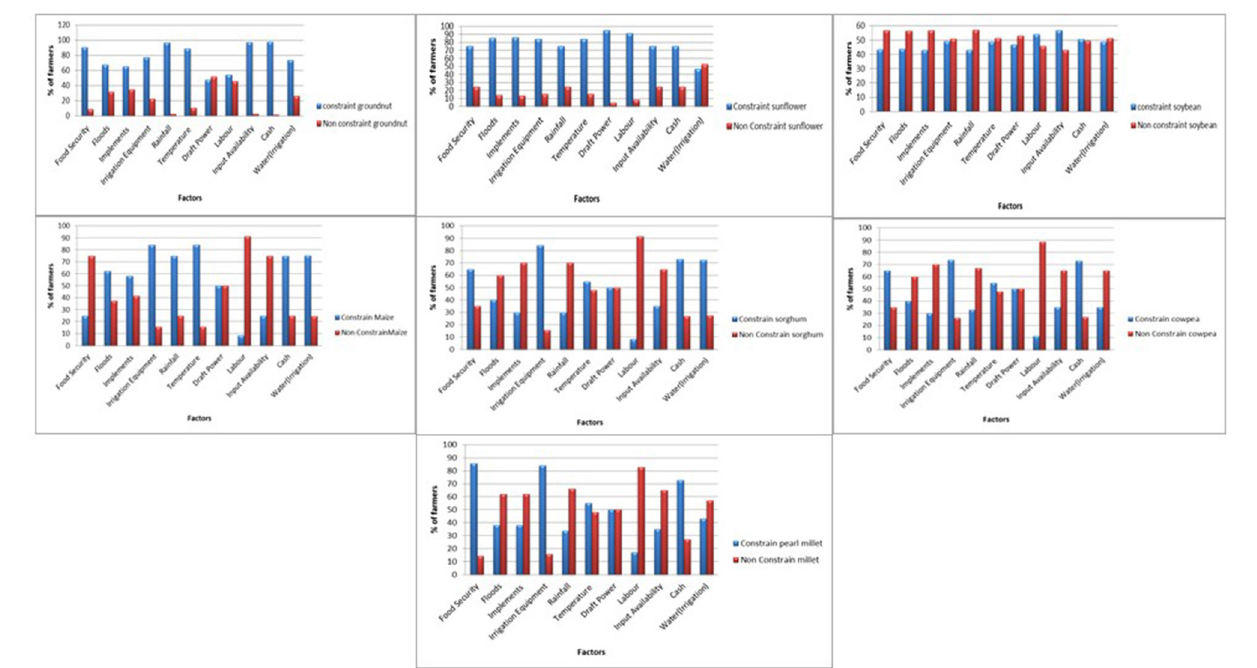
FIGURE 3 | Factors influencing the choice of crops to produce in